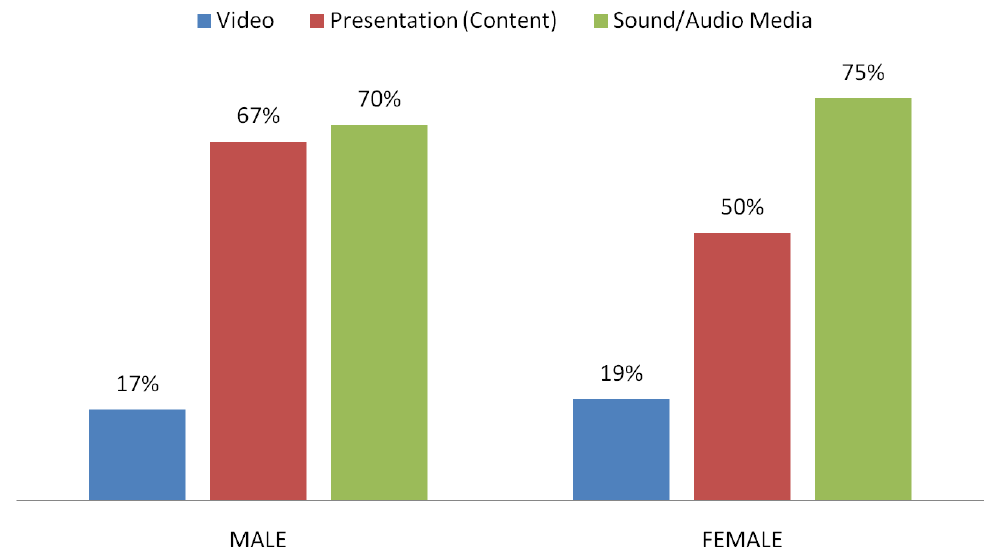
Figure 3. Grouped and adjusted qualitative data as quantitative data from the second part of the evaluation form in three categories of budding journalists based in gender.